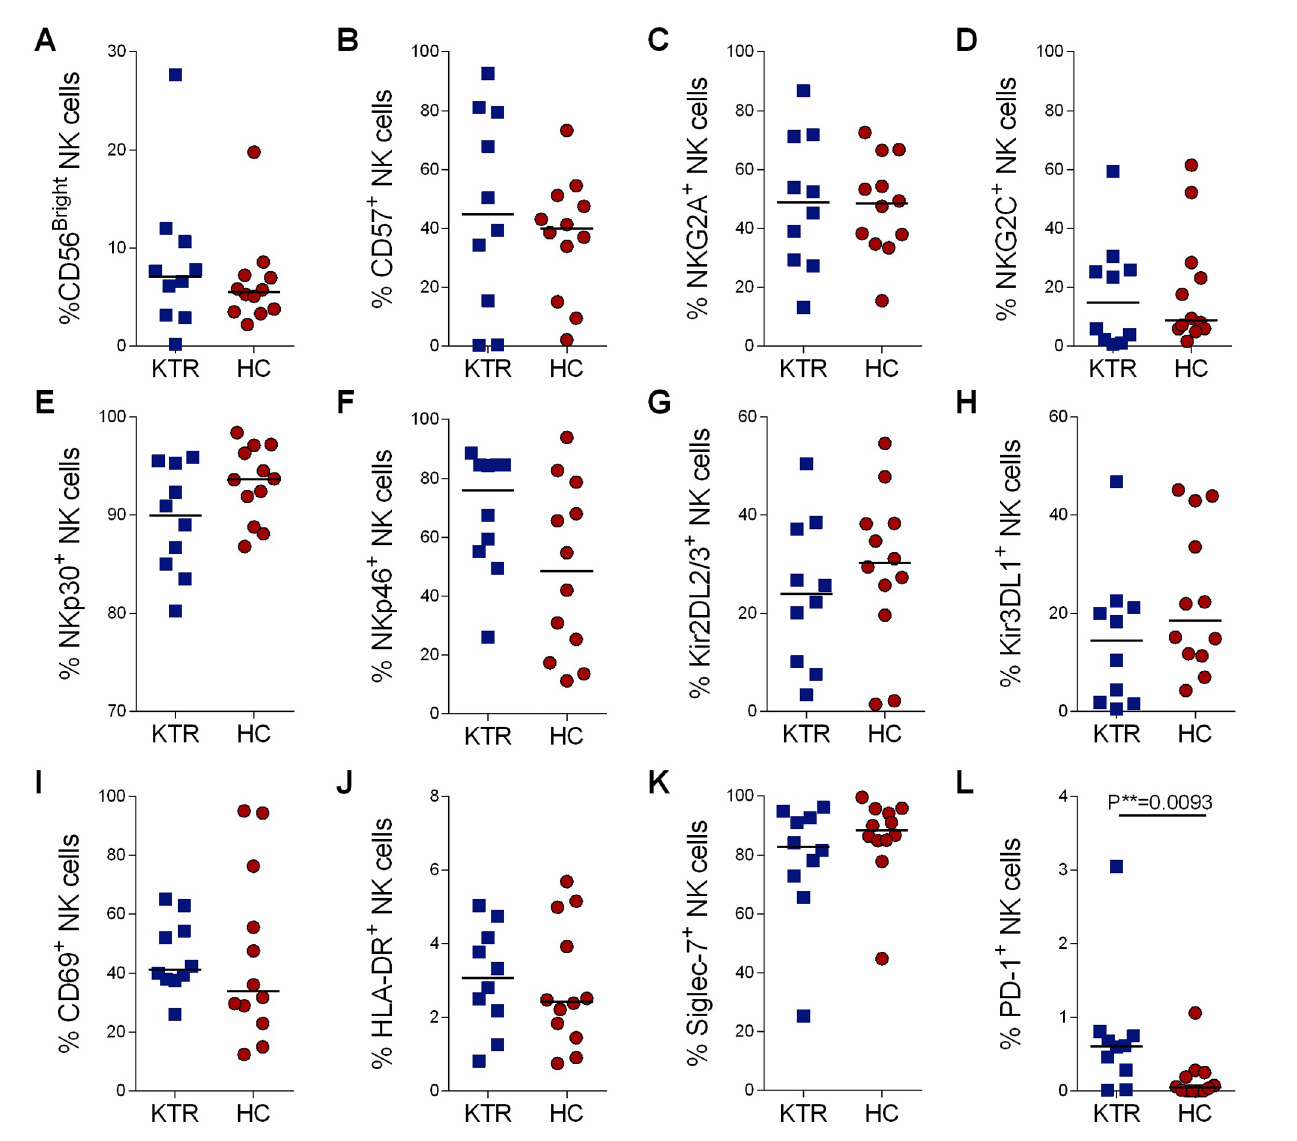
Fig 3. Phenotypic features of NK cells in kidney transplant recipients (KTRs) and healthy controls (HCs). Percentage of A) CD56 Bright , B) CD57 + , C) NKG2A + , D) NKG2C + , E) NKp30 + , F) NKp46 + , G) Kir2DL2/3 + , H) Kir3DL1 + , I) CD69 + , J) HLA-DR + , K) Siglec-7 + and L) PD-1 + in CD3 - CD56 + NK cells from 10 kidney transplant recipients (KTRs) and 12 healthy controls (HCs). Expression was measured at the surface by flow cytometry on thawed PBMCs. Horizontal bars indicate the median. Exact P-values were calculated with a two-tailed Mann-Whitney